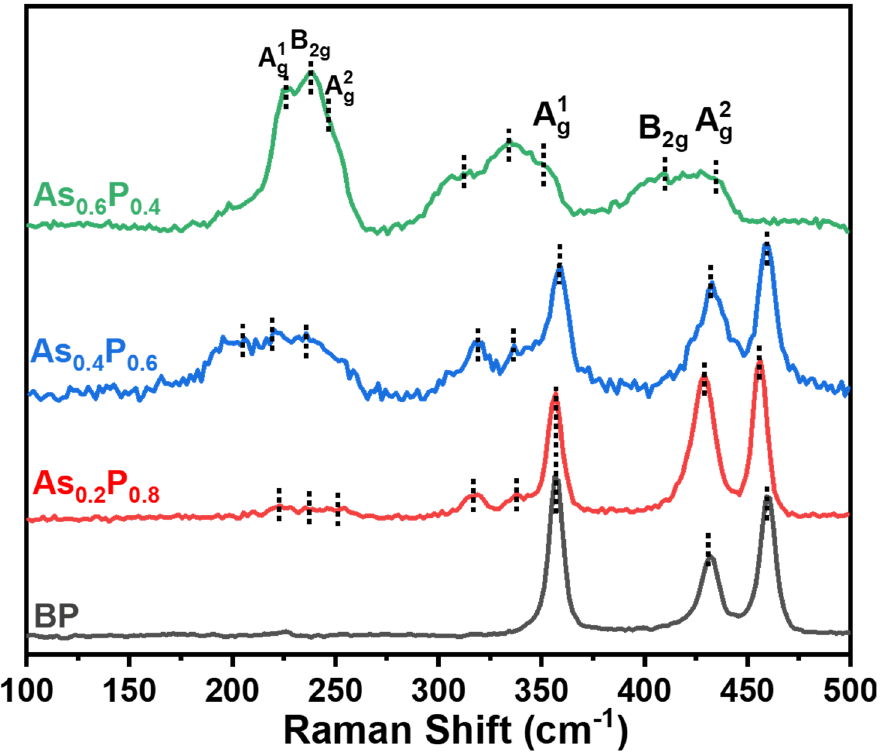
Figure 2. Raman spectra of unexposed synthesized pristine BP and As x P 1 − x alloys with three different chemical compositions.